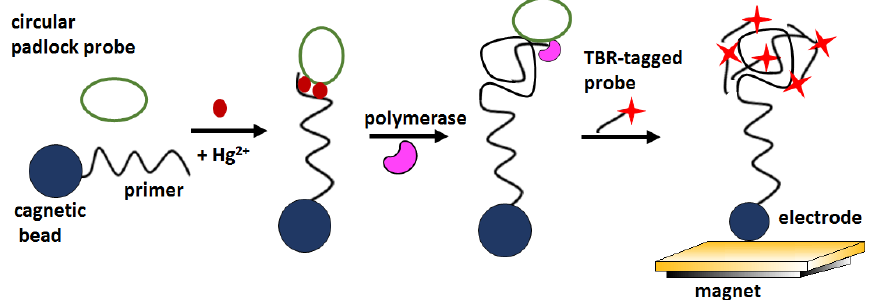
Figure 12. Schematic illustration of detecting mercury ions via ECL aptasensor and RCA amplifica- tion method.